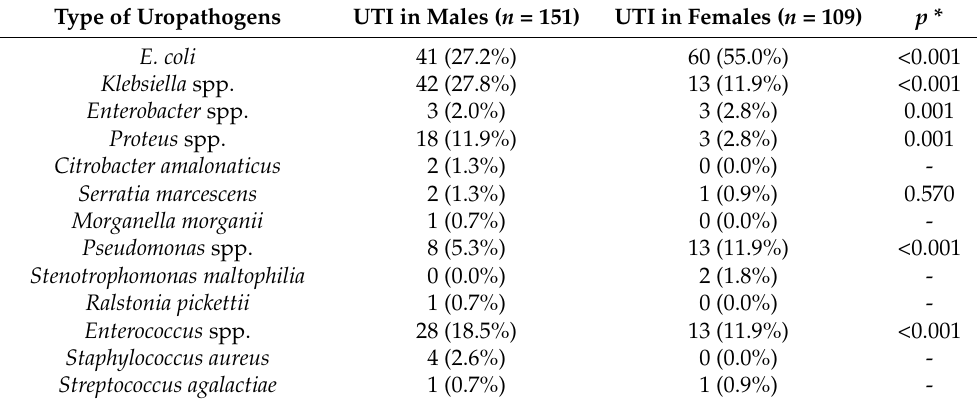
Table 3. Uropathogens causing UTI in children with CAKUT in regard to